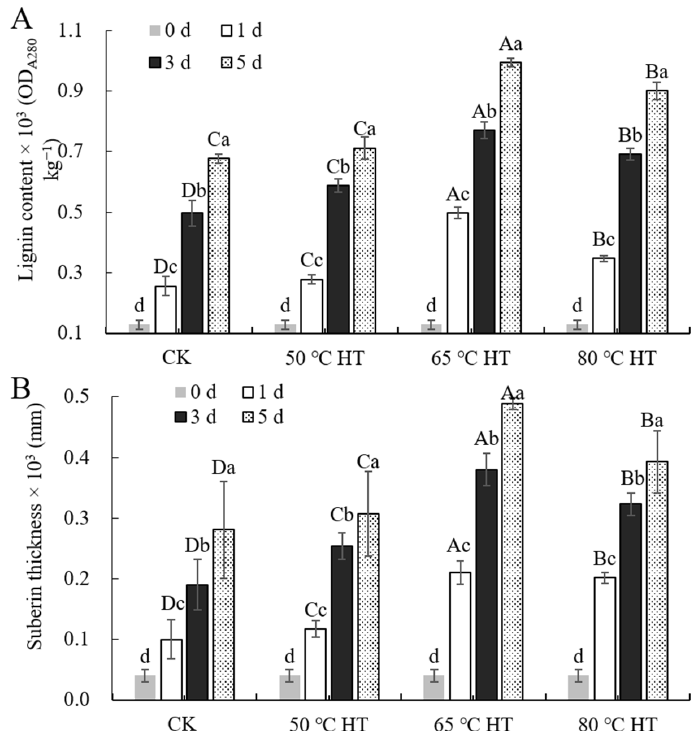
Figure 2. Effects of RHT treatment on suberin thickness and lignin content in sweet potato callus (( A ): Liginn content; ( B ): Suberin thinckness. Note: Capital letters are comparisons at the same time at different temperatures, and lowercase letters are comparisons at different times at the same temperature).